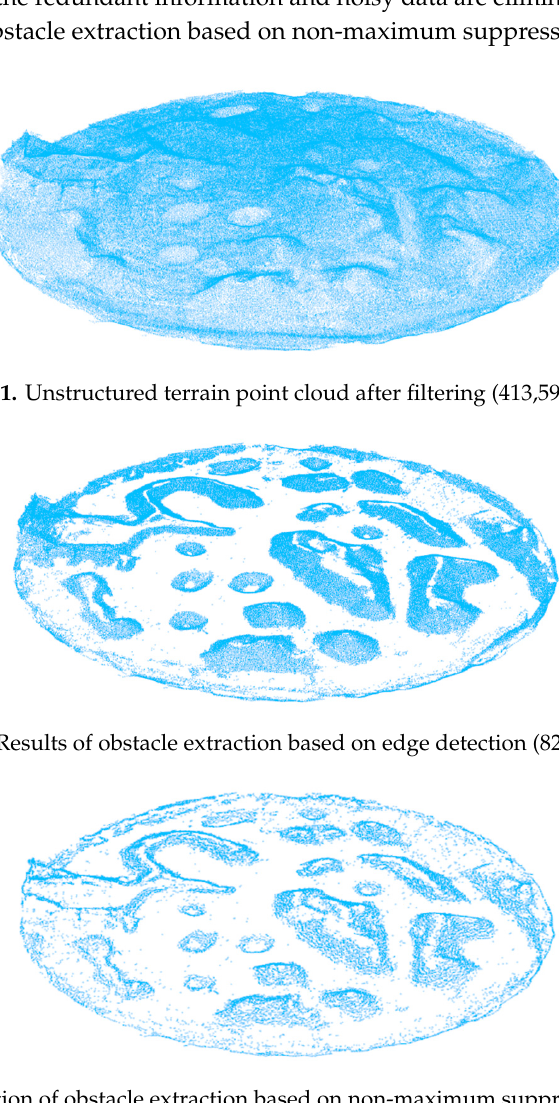
Figure 13. Optimization of obstacle extraction based on non-maximum suppression (26,011 points).